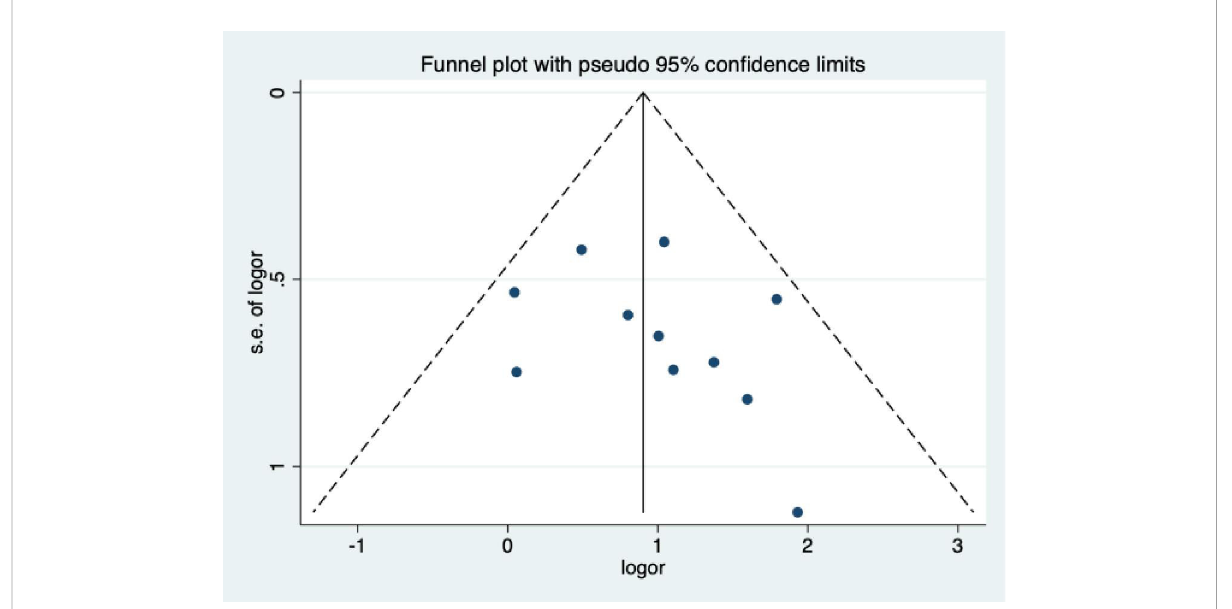
FIGURE 9 Funnel fi gure (The symmetry of the black spots in the image re fl ects the presence of bias).